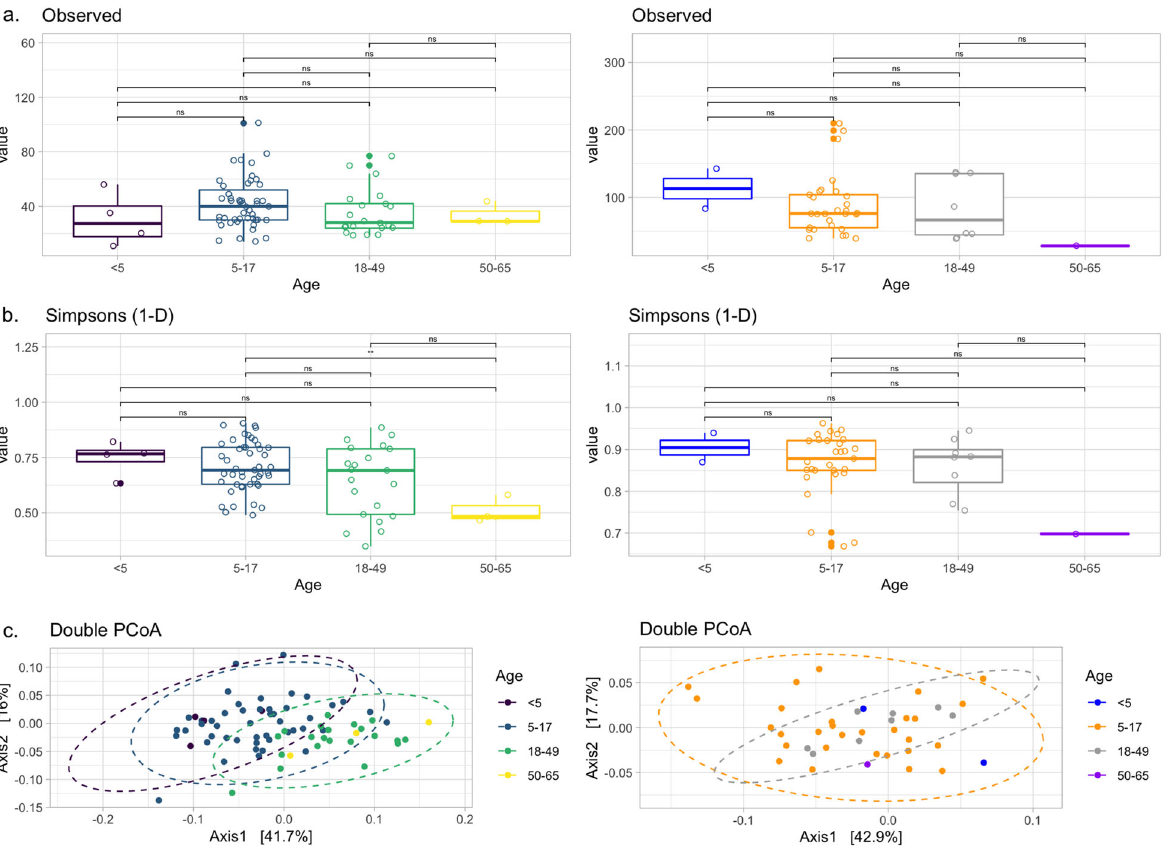
Fig. 4 Alpha and beta diversity of nasal (left column) and oral (right column) samples. Observed richness and Simpsons 1-D (a measure of diversity) are shown in panels a and b respectively. Only a signi fi cant difference (**) was observed for nasal samples for those aged 5 – 17 when compared against 50 – 65 ( p = 0.0023). Beta diversity is shown using Double Principle Co-ordinates Analysis (DPCoA) (panel c ). Here, clusters are observed for nasal samples (left) with grouping based on age group. No clusters were observed for oral samples (right).